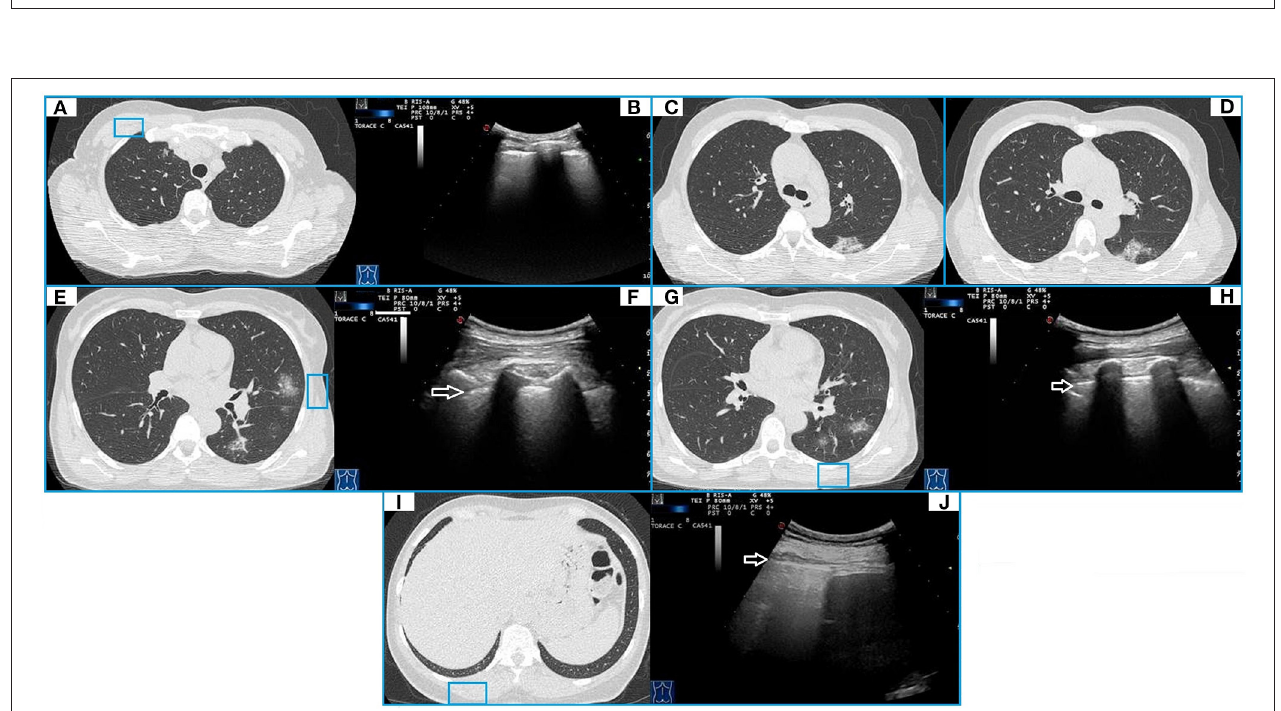
FIGURE 2 | Rate of comorbidities, collateral CT findings, and percentage of patients that showed worsening and required subsequent ICU admission in different groups of initial CT scan severity.